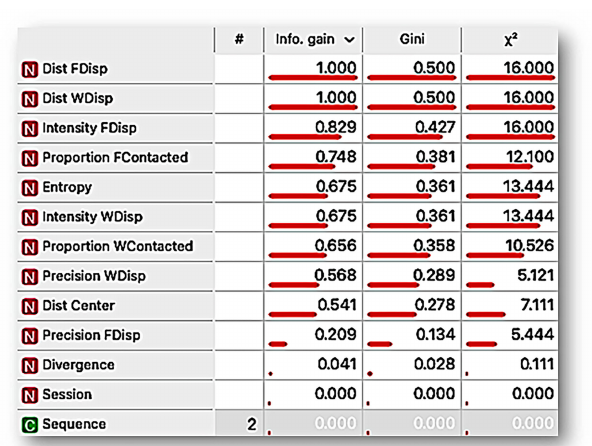
FIGURE 11 | Ranking variable analysis, under information gain , mean decrease impurity Gini index , and χ 2 procedures for the features Distance to food dispenser ( Dist FDisp ), distance to water dispenser ( Dist WDisp ), intensity to food dispenser ( Intensity FDispenser ), Proportion of food contacted ( Proportion FContacted ), Entropy, Intensity to water dispenser ( Intensity WDisp ), Proportion of water contacted ( Proportion WContacted ), Precision to water dispenser (Precision WDisp), distance to the center of the experimental arena ( Dist Center ), Precision to food dispenser ( Precision FDisp ), Divergence, Session,